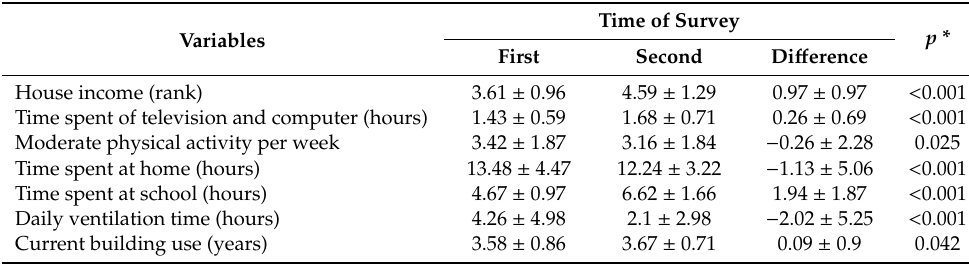
Table 3. Comparison of changes in the individual risk of environmental factors between the first and second survey (continuous